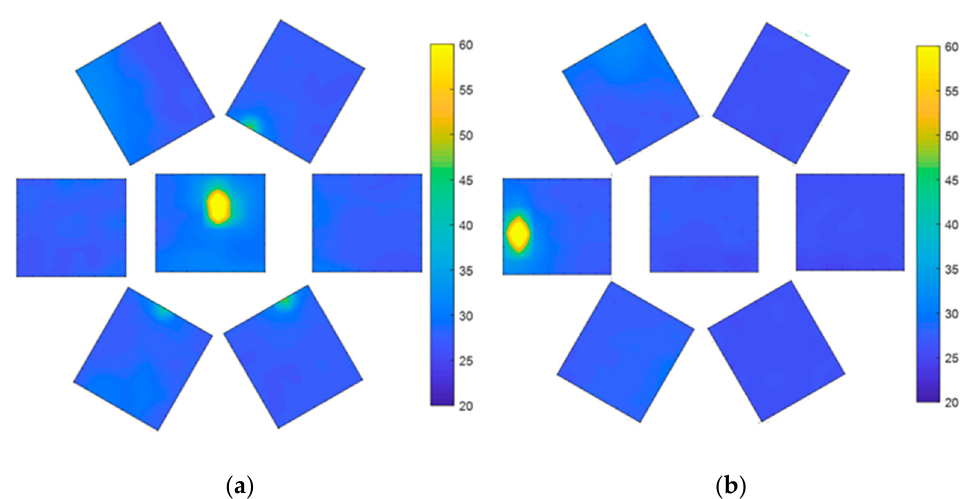
Figure 24. FOV test at 18 kPa. ( a ) Front test image of the compound eye. ( b ) Test image of the edge position of the compound eye rotation field.